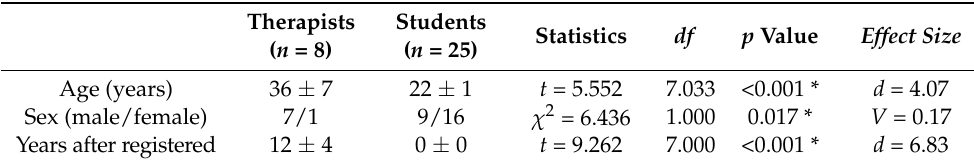
Table 1. Subject